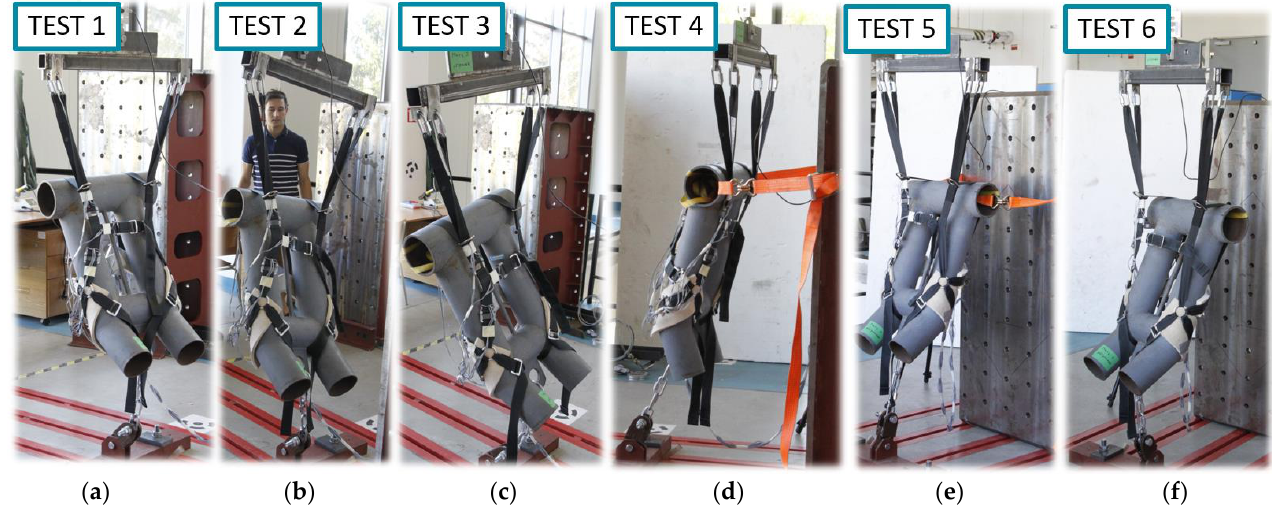
Figure 7. Equilibrium position in the unloaded state for each test case: ( a ) test case 1, ( b ) test case 2, ( c ) test case 3, ( d ) test case 4, ( e ) test case 5, and ( f ) test case 6.